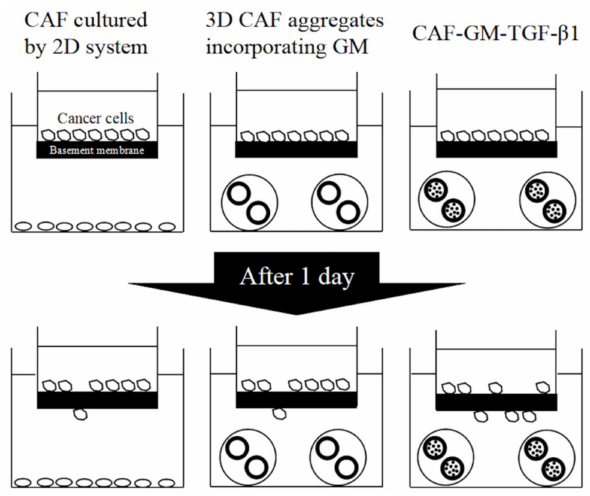
Figure 3. Illustration of cancer invasion based on a combination of 3D cell culture and drug delivery system